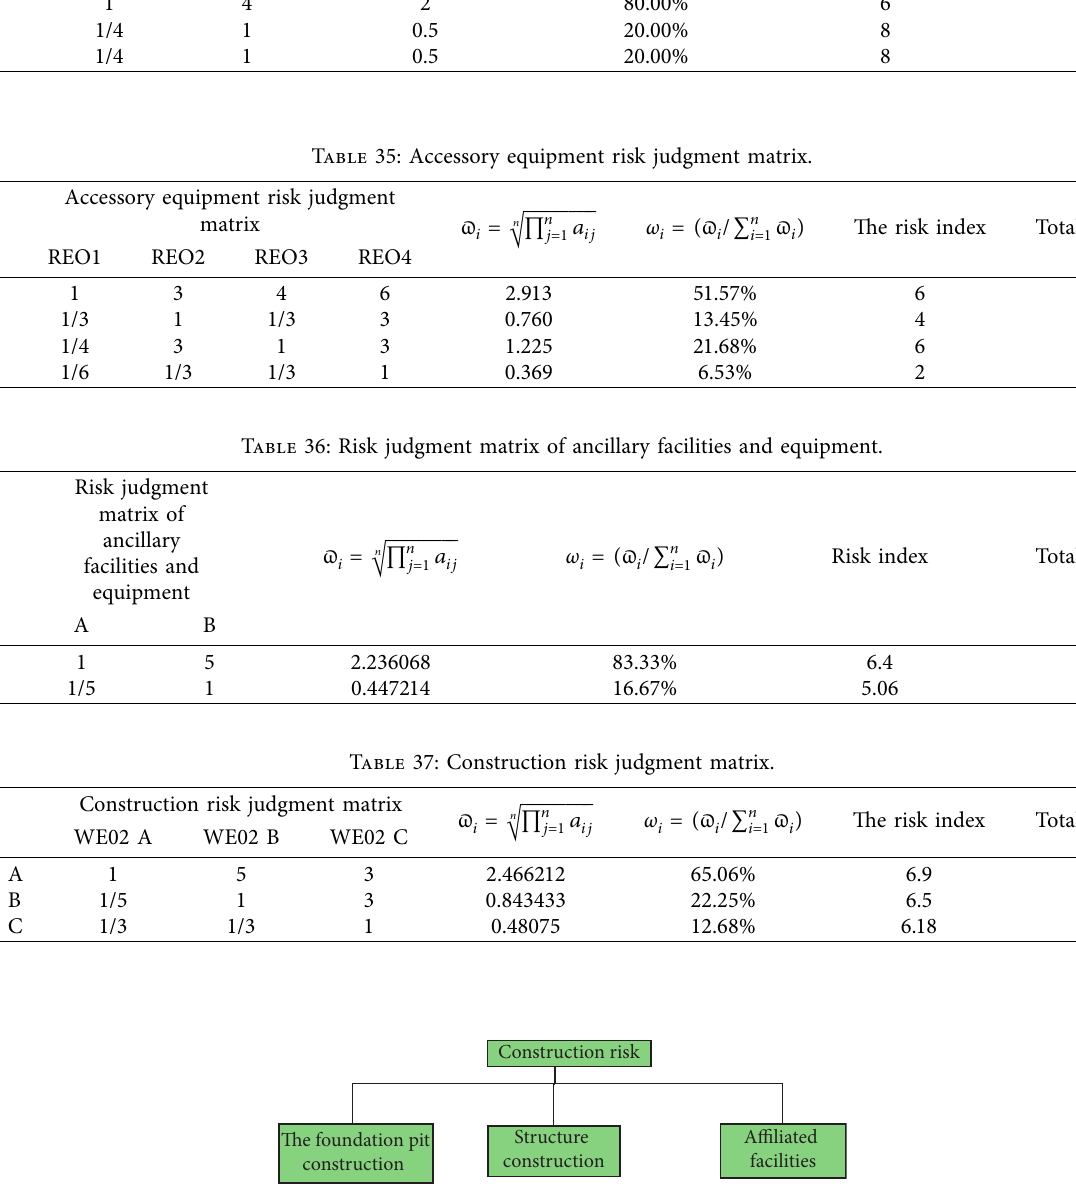
Figure 7: Construction risk hierarchy